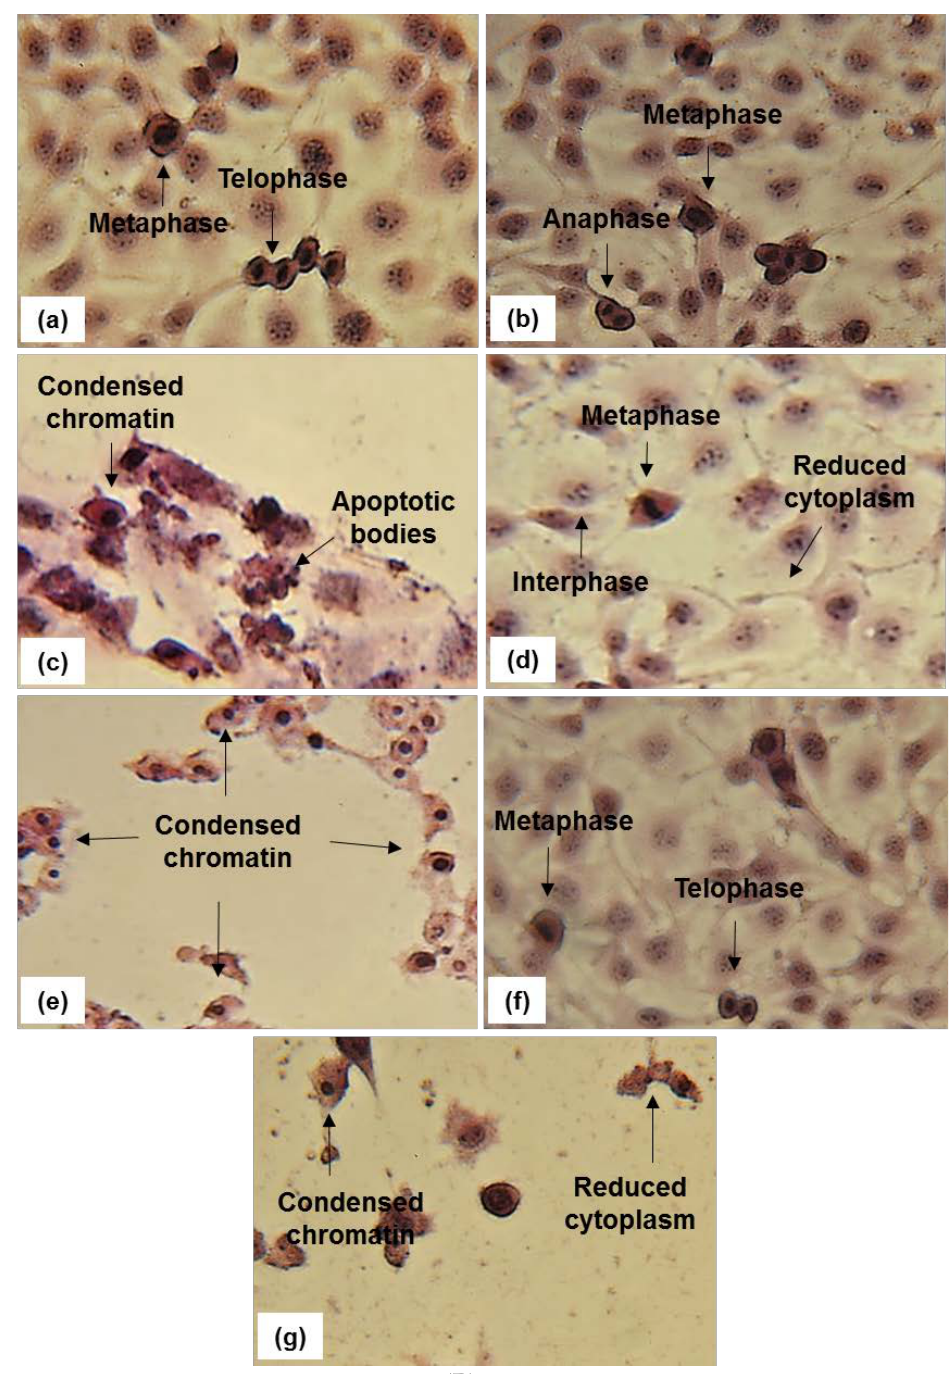
Figure 4. In ( A ) Hematoxylin and eosin staining (20 and 40× magnification) of UCT − MEL − 1 cells after 48 h exposure to; ( a ) media (untreated) control, ( b ) 0.25% DMSO (vehicle) control, ( c ) 0.025 µg/mL actinomycin D (Act D) positive control, ( d , e ) Buddleja saligna extract (30 and 60 µg/mL) and ( f , g ) isolated triterpenoid mixture DT − BS − 01 (5 and 20 µg/mL). Data are representative of one of two similar experiments. In ( B ) Hematoxylin and eosin staining (20 and 40× magnification) of HaCat cells after 48 h exposure to; ( a ) media (untreated) control, ( b ) 0.25% DMSO (vehicle) control, ( c ) 0.025 µg/mL actinomycin D (Act D) positive control, ( d , e ) Buddleja saligna extract (30 and 60 µg/mL) and ( f , g ) isolated triterpenoid mixture DT − BS − 01 (5 and 20 µg/mL). Data are representative of one of two similar experiments.